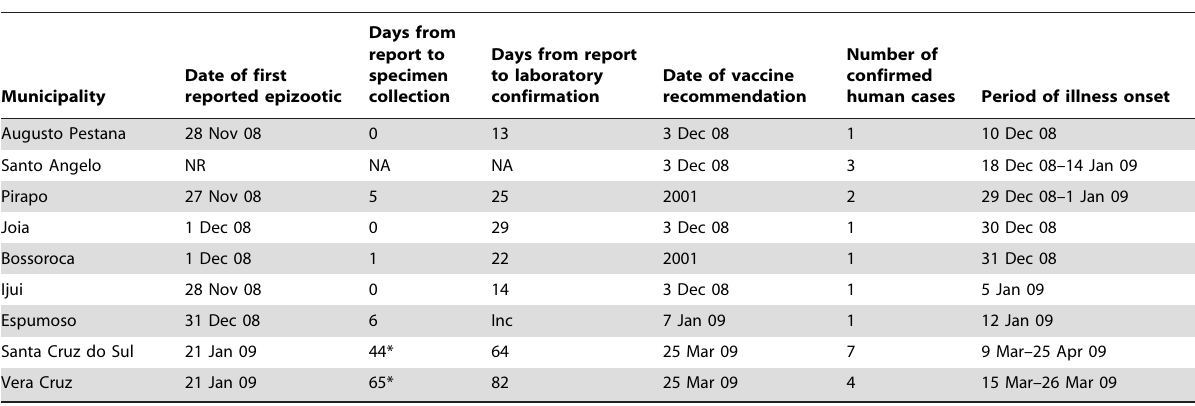
Table 2. Timeliness of yellow fever vaccine recommendations.